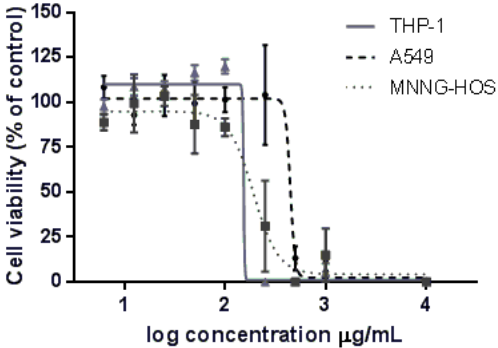
Figure 3. Dose-response effect of Laurencia obtusa crude extract on cell viability in different cancer cell lines. Cells were treated with different concentrations of crude extract for 24 h. Data-points correspond to the mean ± SEM of at least three independent assays. Dose-response curves were fitted to a sigmoidal function to calculate the IC 50 values. Table 4. IC 50 values (µg/mL) of Laurencia obtusa crude extract in different cancer cell lines. Cell Lines